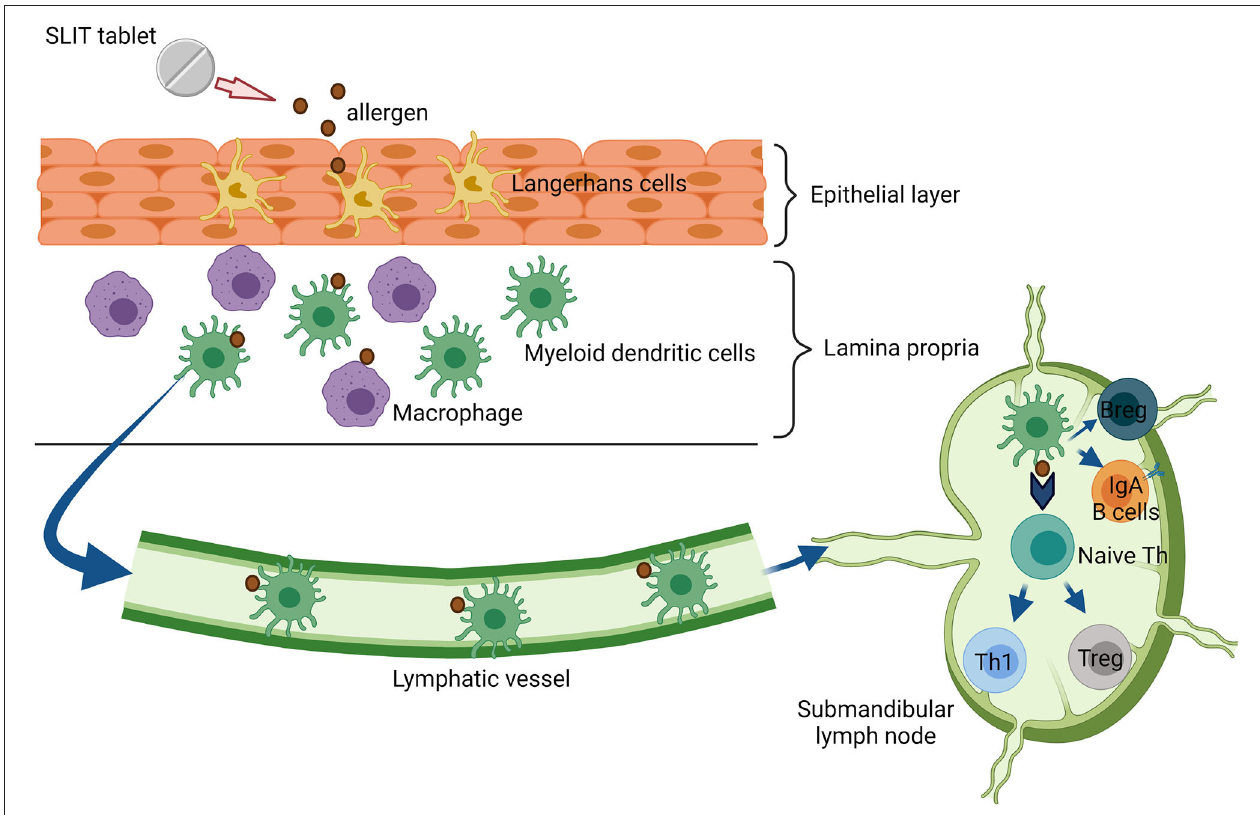
FIGURE 2 | Immunologic mechanism of sublingual immunotherapy (SLIT). Substantial amounts of allergens from SLIT-tablet are capture by Langerhans cells in the epithelial layer. Next, the allergen is processed and migrated transmucosal by myeloid dendritic cells (mDCs) to draining lymph nodes. In the lymph node, these cells interact with T and B cell priming to regulate immune